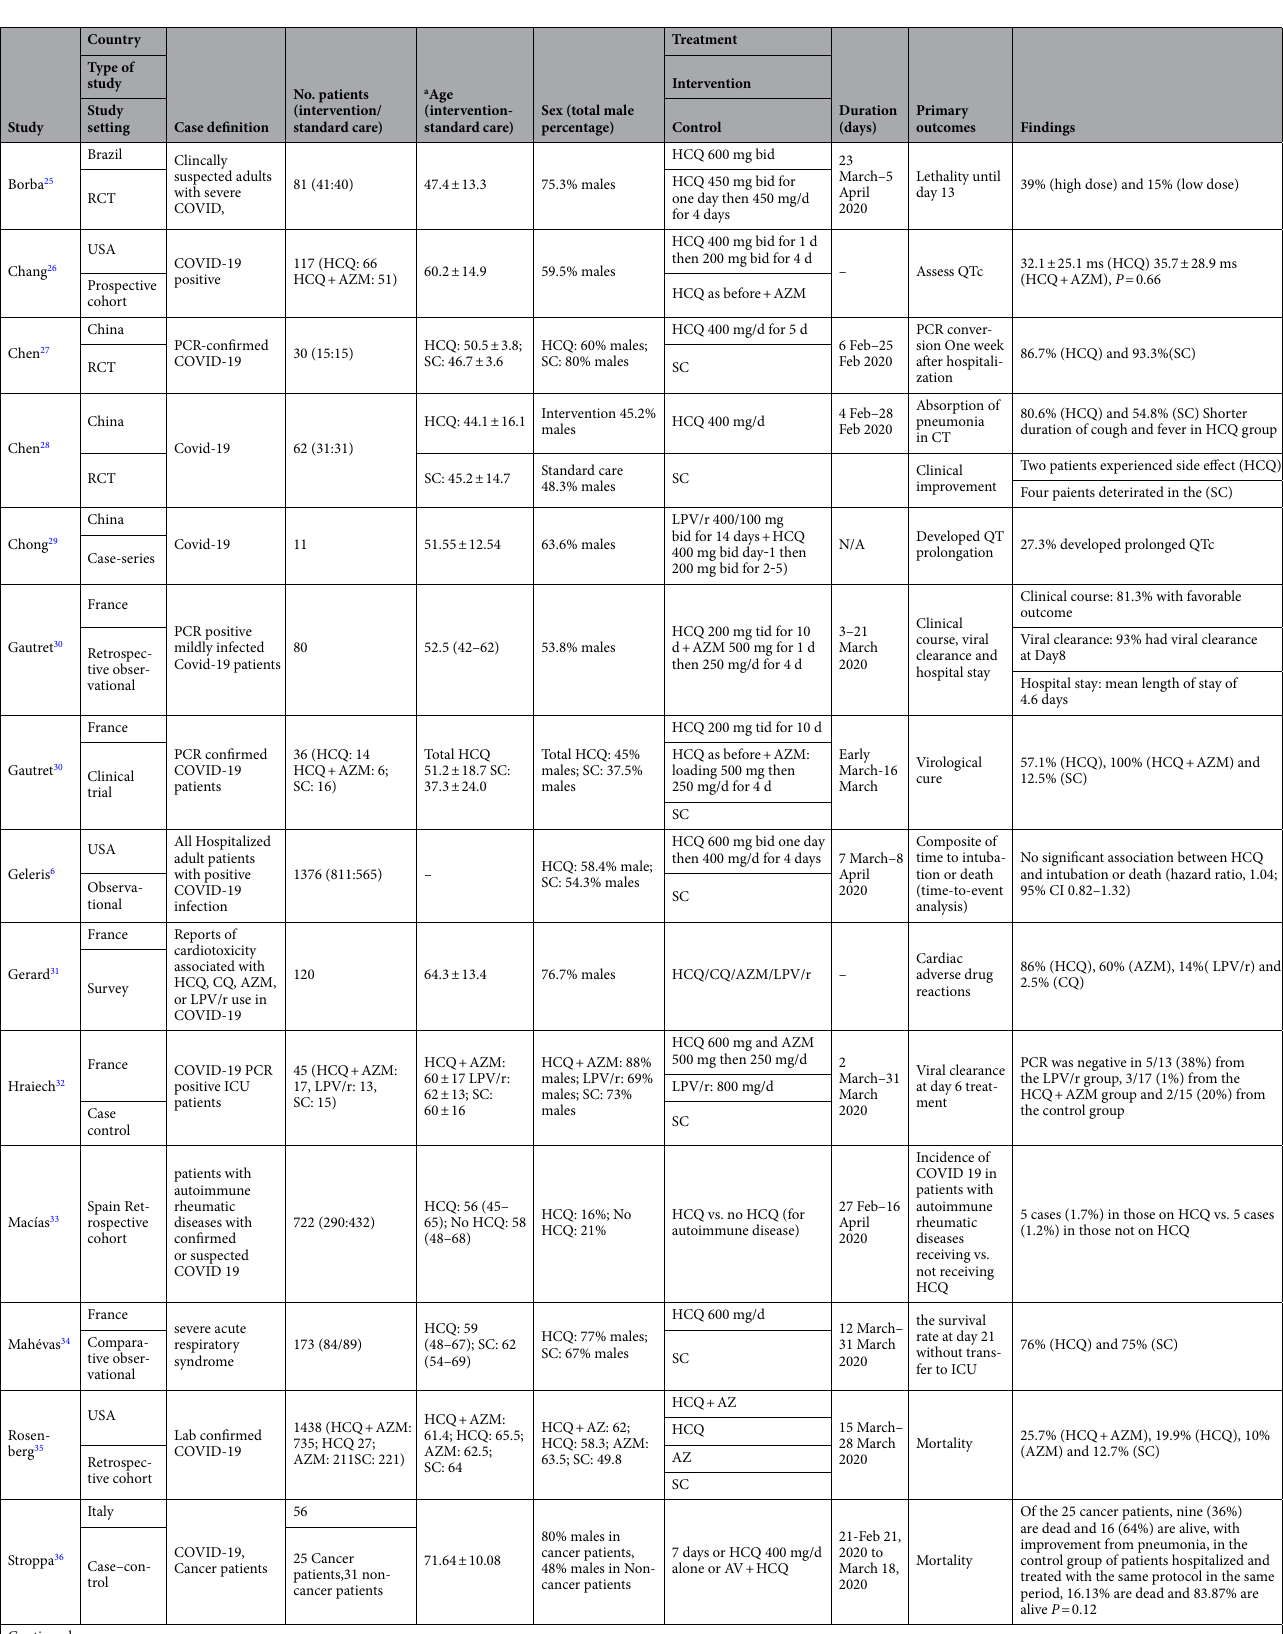
Of the 25 cancer patients, nine (36%) are dead and 16 (64%) are alive, with improvement from pneumonia, in the control group of patients hospitalized and Mortality treated with the same protocol in the same period, 16.13% are dead and 83.87% are alive P =